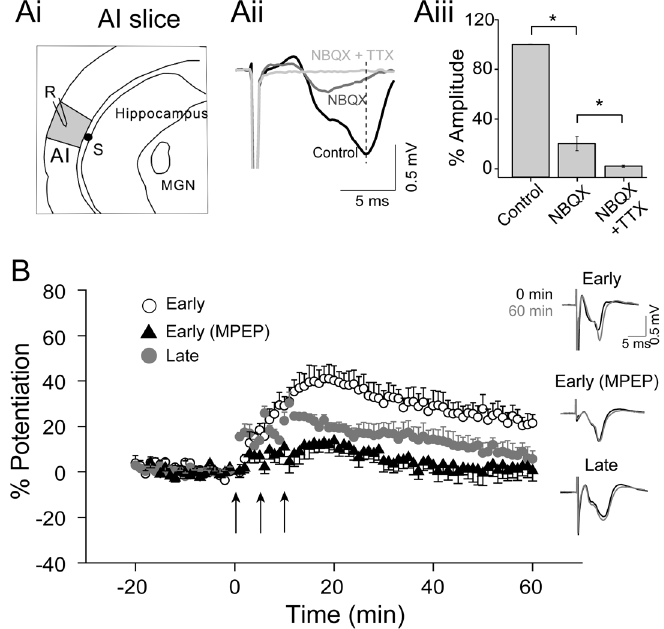
Figure 1. Differential LTP expression in early- (P16-20) and late-age (P27-31) windows. Ai . A schematic of experimental setup. S, stimulus (black dot); R, recording (Layer III/IV). Aii . Field potential responses in the presence of NBQX and/or TTX. Aiii . Field potential amplitude measured at the peak latency (see dashed vertical line in Aii ) was reduced by 80% by NBQX, and was completely abolished by further TTX application. B . Average responses in early- and late-age groups. Note the significant LTP in the early-age group but not in the late-age group. LTP in the early-age group was completely blocked by MPEP application. Insets show overlapping field potential traces before (black) and 60 min after (gray) LTP induction. Arrows indicate three consecutive tetanic stimulations. *, p , 0.05.